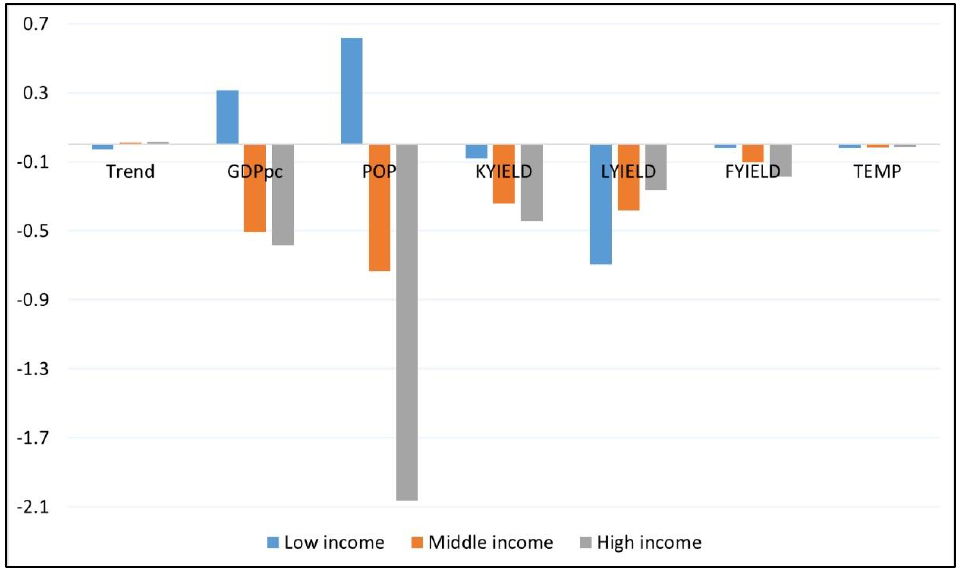
Figure 3. Elasticities of determinants on the WF by income groups. Elasticities are estimated with specification M4, segmented by income groups. GDPpc refers to Gross Domestic Product per capita; POP is population; TEMP refers to the temperature change; and KYIELD, LYIELD and FYIELD is the capital, labour and fertilizer yield, respectively.